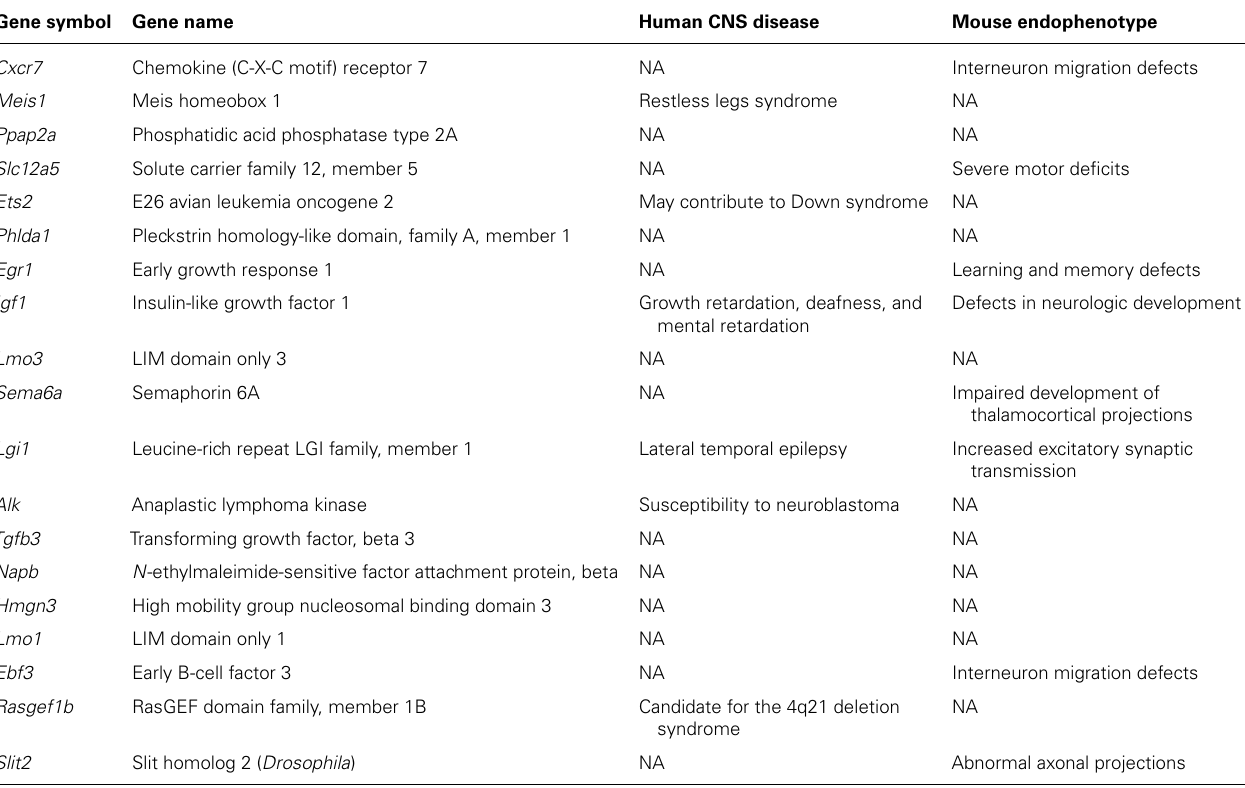
Table 1 | List of candidate genes regulated byArx and controlling cortical interneuron migration and/or